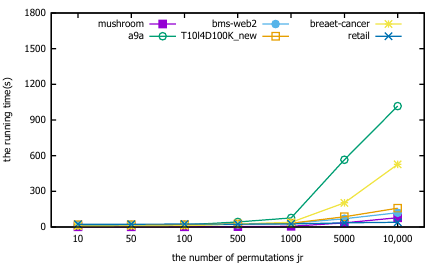
Figure 10. Run time changes.